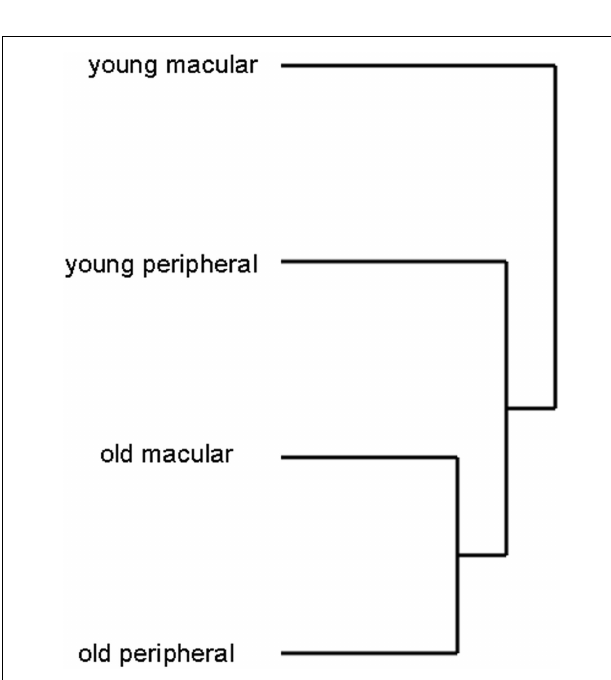
FIGURE 4 | Hierarchical clustering analysis of retinal samples shows old and young retina (macular and peripheral) cluster separately, suggesting that aging changes the expression profile more than location (macula vs. periphery). Young macular and peripheral samples were from different individuals for this analysis. Likewise older macular and peripheral samples were from different individual